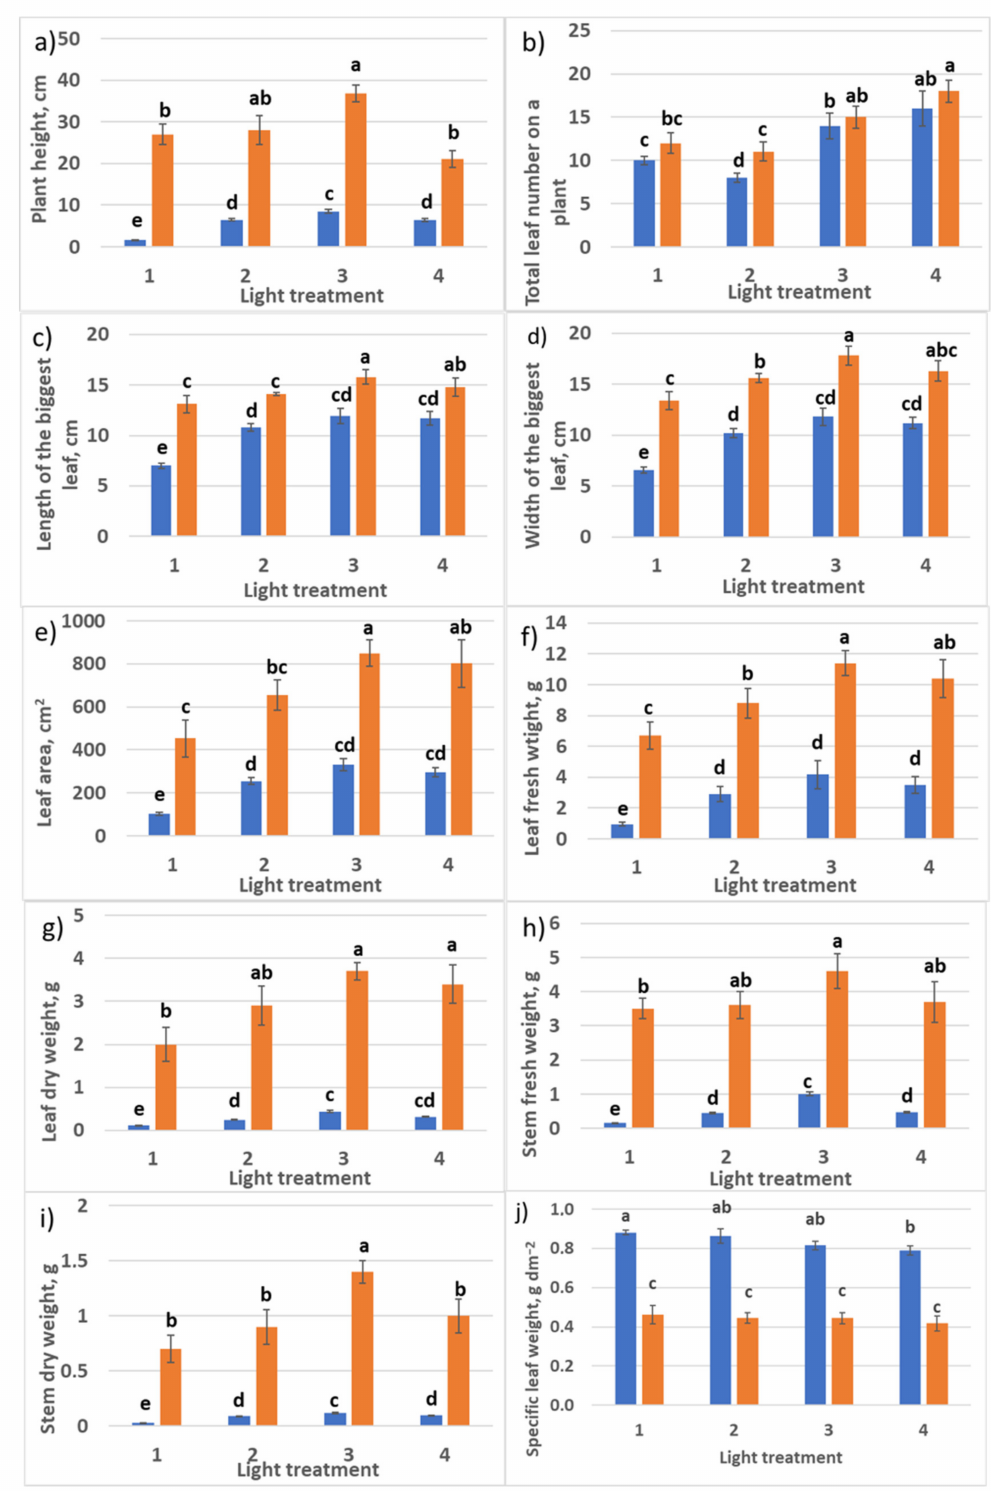
Figure 3. Growth parameters of raspberry plants as affected by different red (R 660 )–far-red (FR)light ratio. Sampling 30 days (blue columns) and 60 days (orange columns) after transplanting. Means ± standard error (SE); means followed by. ( a ) Plant height; ( b ) total leaf number per plant; ( c ) length of the biggest leaf; ( d ) width of the biggest leaf; ( e ) total leaf area; ( f ) total leaf fresh weight; ( g ) total leaf dry weight; ( h ) stem fresh weight; ( i ) stem dry weight; ( j ) specific leaf weight. Means followed by the same letter were not different at p ≤ 0.05. Treatment 1—0% R 660 + 100% FR; Treatment 2—30% R 660 + 70% FR; Treatment 3—70% R 660 + 30% FR; Treatment 4—100% R 660 + 0%